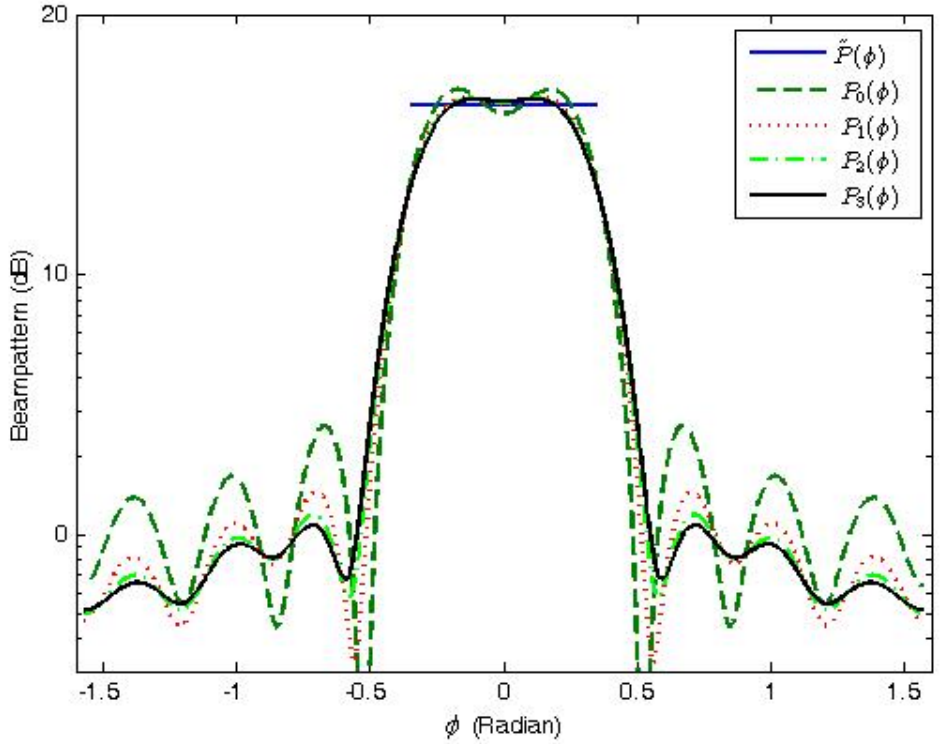
2 Figure 2. The transmit beampatterns after using the cosine method 1–3 times ( M =